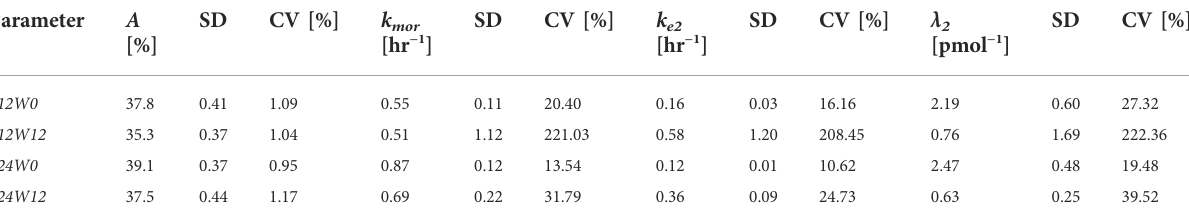
TABLE5EstimatesoftheModelfreeparametersalongwiththerespectivestandarddeviationsandcoef fi cientsofvariation,atthebeginning(week0) and at the end (week 12) of the study for the two treatment regimens, from the second optimization